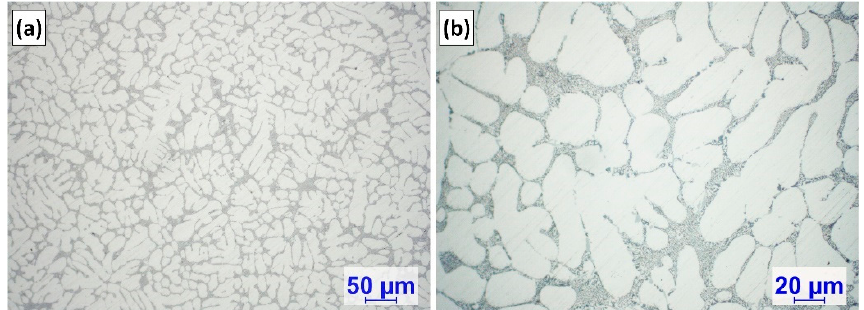
Figure 3. ( a , b ) Microstructural images of the OES sample cast 10 min after Ti-alloying during the A2 experiment.